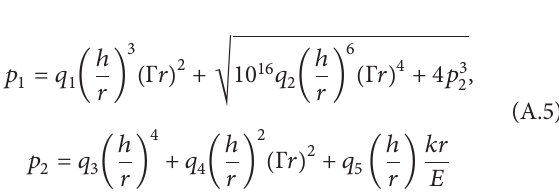
− (𝑟 𝜁 ) 𝑁 𝑁 𝑘𝑟 𝑁 /𝐸=0.1 . 𝑁 /𝐸=0.001